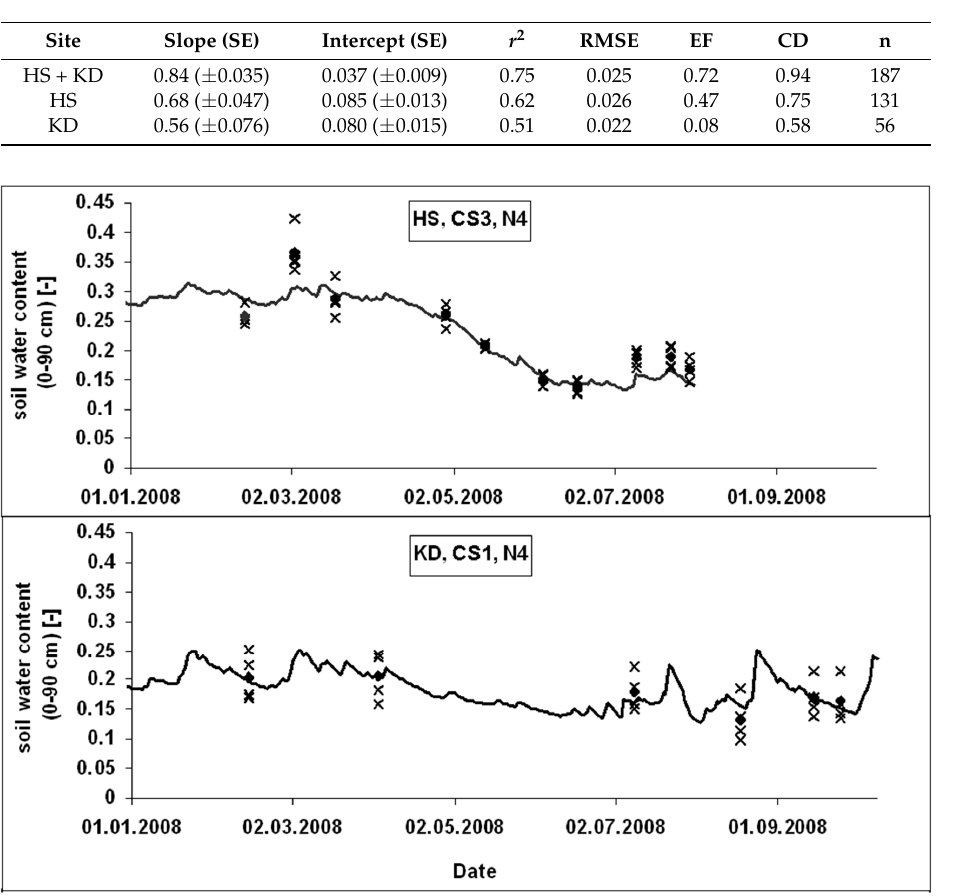
Table 7. Model performance for soil water contents in the soil layer from 0–90 cm calculated for all data (HS + KD) of the field experiment and separately for each site (Hohenschulen (HS) and Karkendamm (KD)). Statistical parameters are slope, intercept and their SEs and r 2 of the linear regression between the measured and simulated results, RMSE, EF, CD, and n.